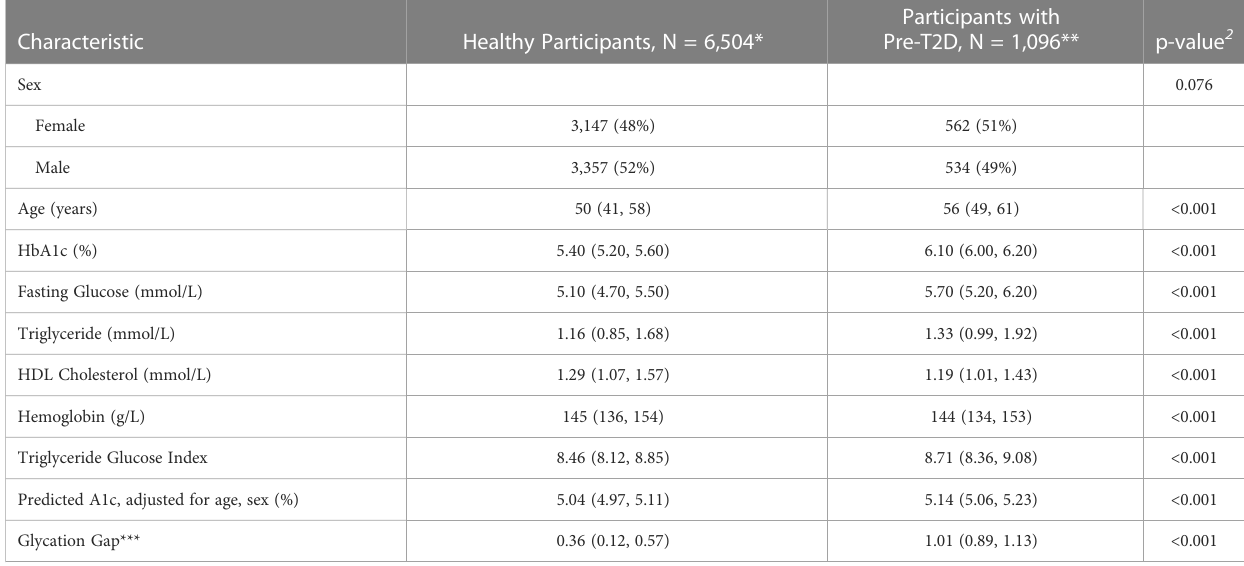
TABLE 2 Baseline characteristics for participants of observational study.